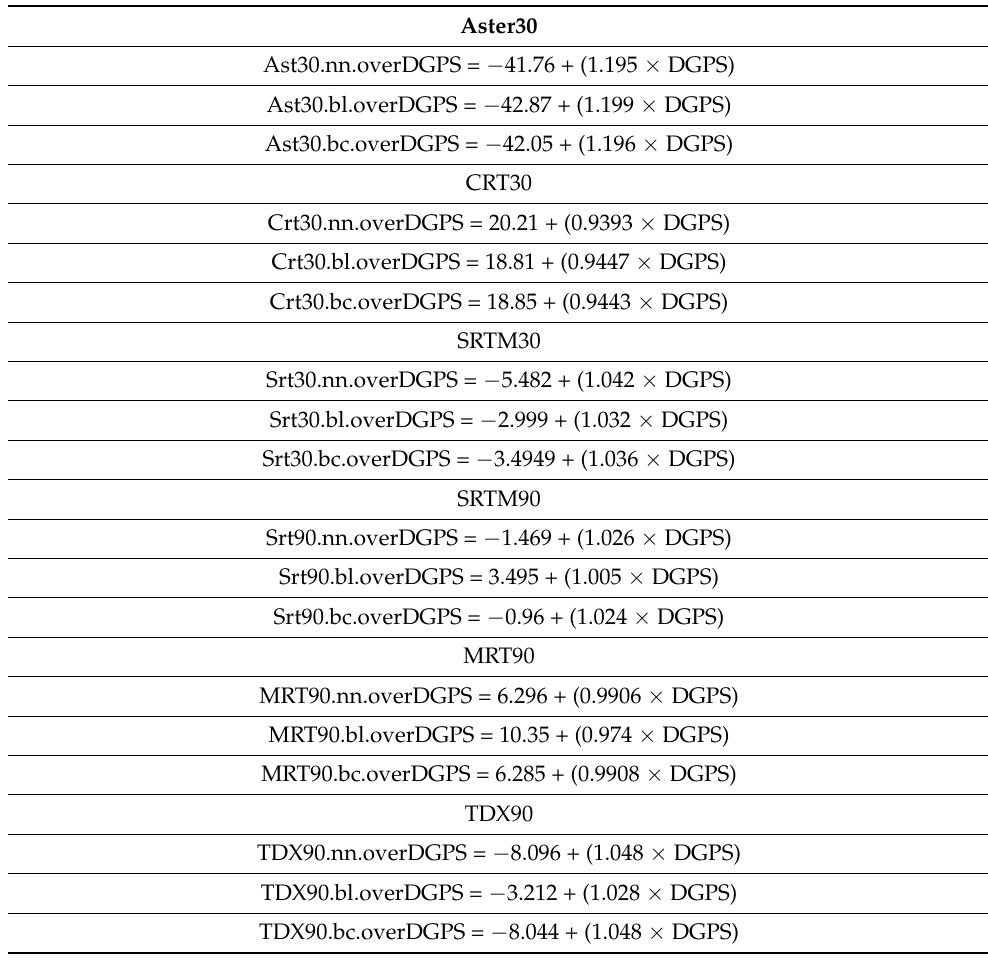
Table 5. Linear fit based equations, used for correction, exhibiting relation between space-borne ele- vations (resampled using different interpolation methods) with DGPS. The nn, bl, and bc refer to the interpolation methods (nearest neighbour, bilinear, and bicubic, respectively) used in the extraction of elevation values from space-borne DEMs over the GCPs. (Ast30 = ASTER GDEM V3, Crt30 =